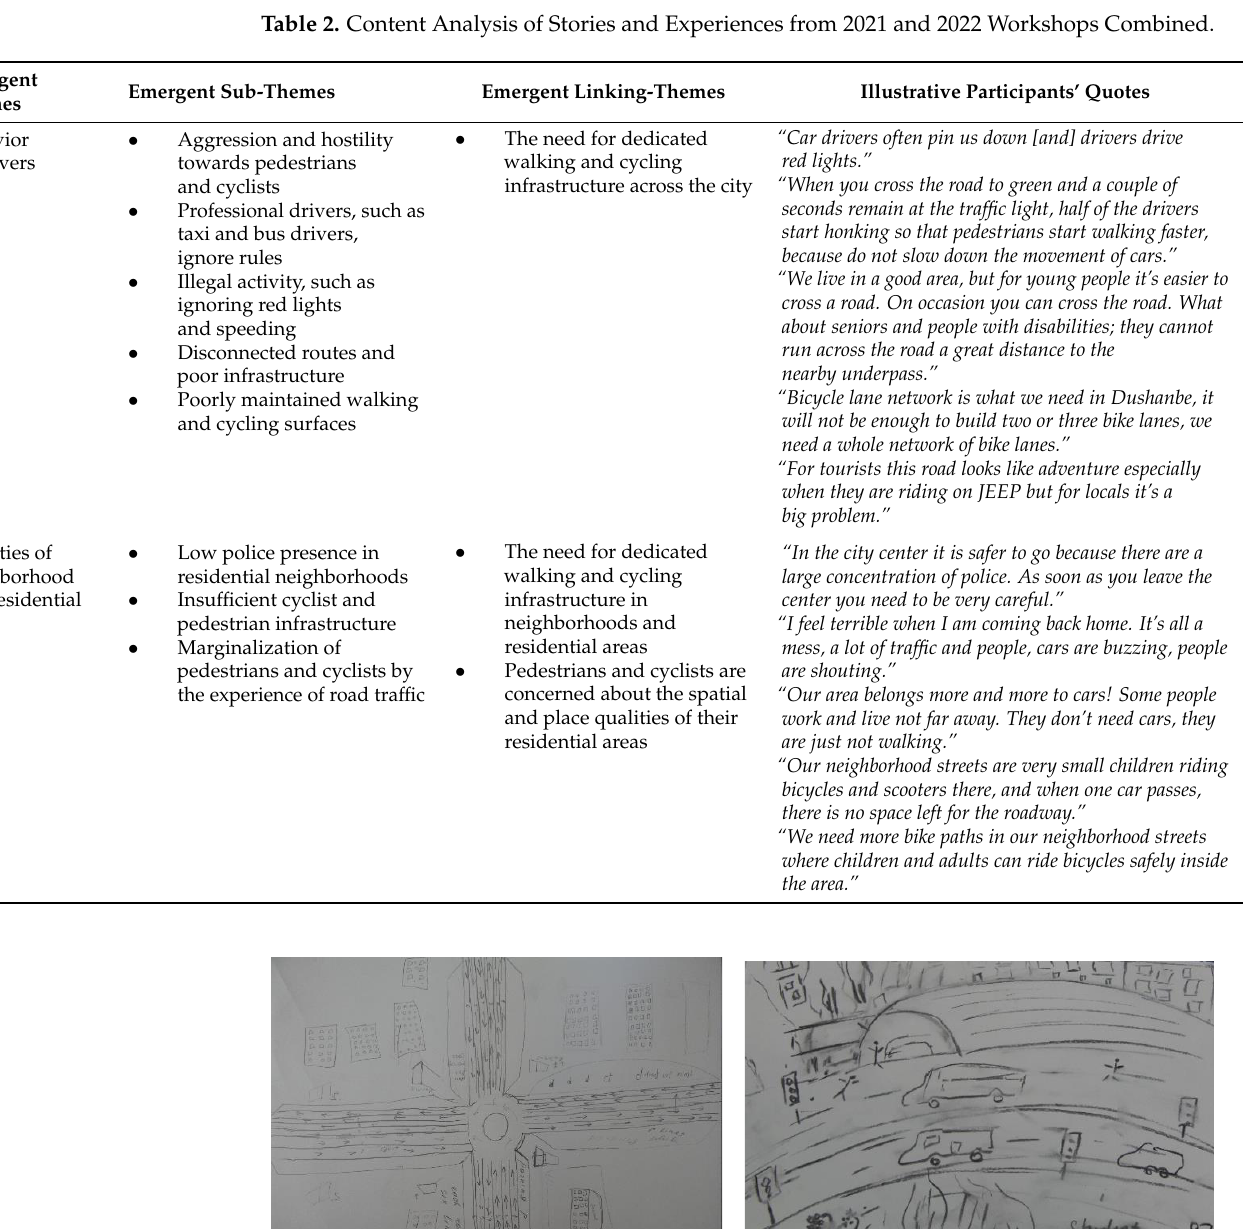
Figure 9. ( a ) and ( b ) Student participants of the 2021 workshop provided drawings of their experi- ences as cyclists and pedestrians at a road junction near the neighborhood bazaar in the Sakhovat district: a landscape of perceived overwhelming noises, smells, and lack of cognition (courtesy of the Young Generation of Tajikistan).